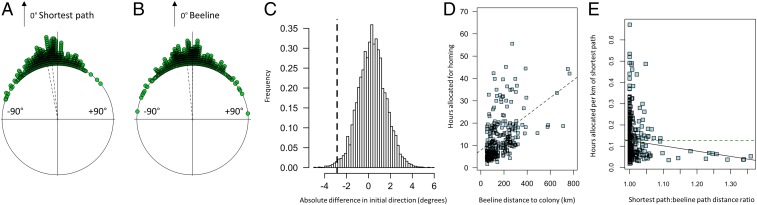
Details of the homing orientation and timing are shown. The initial orientation of shearwaters are shown A with respect to the minimum path flying only over water (mean respective orientation: −8.31°; 99% CI: −5.7° to −10.7°) and in B to the beeline path blind to intervening obstacles (mean respective orientation: −2.56°; 99% CI: +0.3° to −5.4°). A significant difference between these orientation distributions shows that the shearwaters’ initial orientations were not random with respect to the difference between the beeline and minimum path routes home. The dashed lines show the 95% confidence intervals of each set of relative orientations, respectively. (C) To ensure that the beeline orientation observed in A and B was not the result of a bias in both the initial orientation of shearwaters and a global bias in the difference between the 2 tested routes, we computed a randomization to provide a P value. We subtracted each bird’s deflection from the shortest path over only water from its deflection from the beeline, giving negative values for initial orientation closer to the beeline and positive closer to the shortest path over only water. To compute a null expectation for this measure (the histogram shown), we computed this for 10,000 randomly selected startpoint minimum paths and beeline routes. The black line shows the observed “beeline closeness” for startpoints where the resulting difference in route length was >5%. (D) The hours that shearwaters began their journey before midnight as a function of the beeline distance to the colony. (E) Scatter plot showing the decrease in time allocated to homing per unit distance as the ratio between the shortest path and beeline routes becomes large.